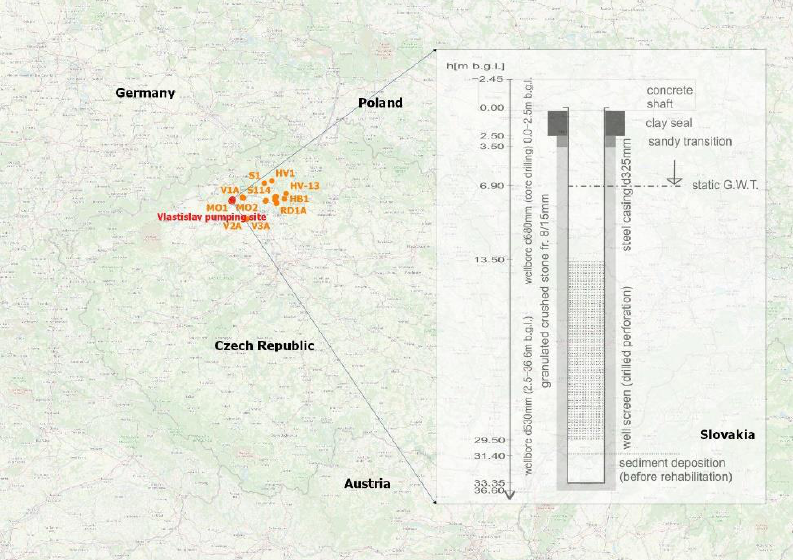
Figure 6. Location of the MO-4 well and a schematic view of the well. The site was established in the 1960s by utilizing a spring tributary (a so-called “chapel”) to a local creek called “Modla”. In total, five new pumping wells were constructed to enhance the pumping capacity of the site. In 1967, the MO-4 pumping well was drilled to a final depth of 36 m. The drilled diameter is 530 mm, with a steel-casing diameter of 325 mm. The well screen consists of a drilled perforation, and the filter is made of granulated stones fractionated to 8/15 mm. The pumping well is screened in a phreatic aquifer, with an initial pumping capacity estimated at up to 5